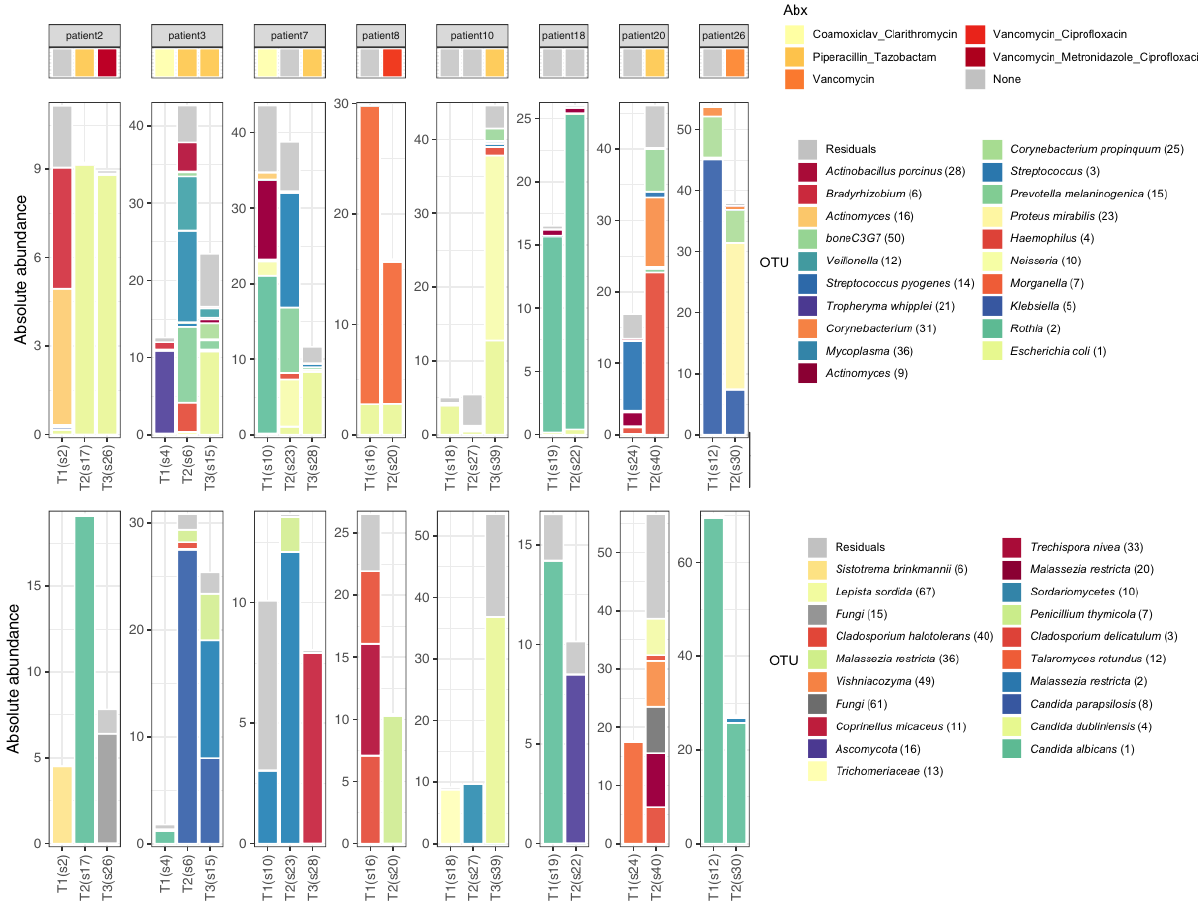
Figure 4. Microbiota changes over time on a per-patient basis. The first row displays antimicrobial treatment. Second and third rows show a stacked bar chart of the absolute abundance of the 20 highest-ranked OTUs and of residual bacteria and fungi